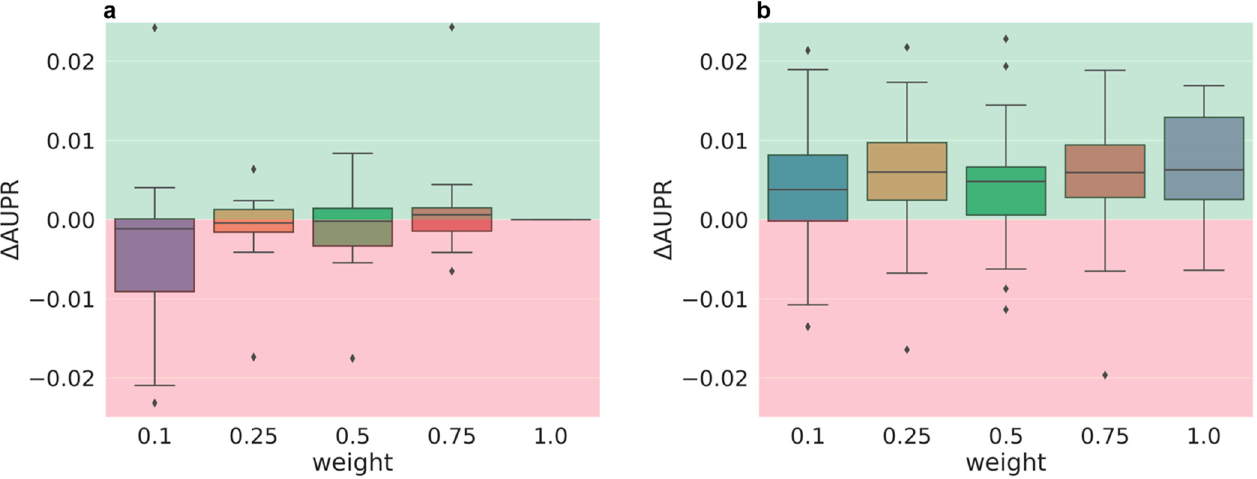
Figure 1. Phase I delta performances (AUPR) of a fixed weighting scheme with threshold 1000 and different weights averaged over 5 partners and 5 folds. ( a ) Synoptic performance (median and lower quartile tasks) and ( b ) sole quartile task performance compared to the synoptic performance of a weight of 1/task_number, where ( a ) both or ( b ) only quartile tasks are considered. Weight of 1.0 in x-axis labels is equal to 1/task_number. Green: better performance than 1/task_number, red: worse performance.